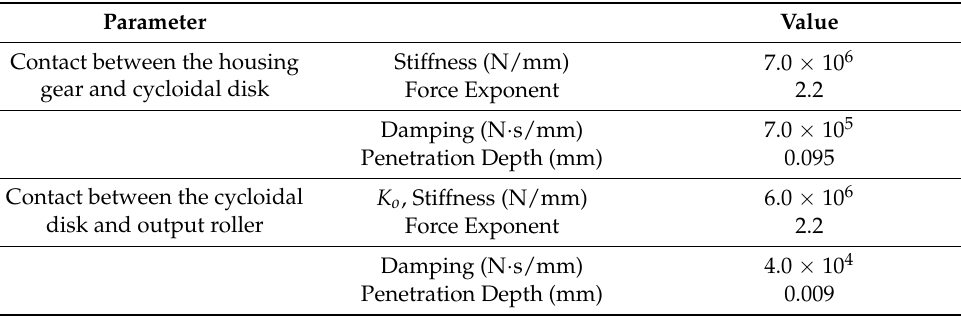
Table 1. Parameters used in the dynamic simulations.